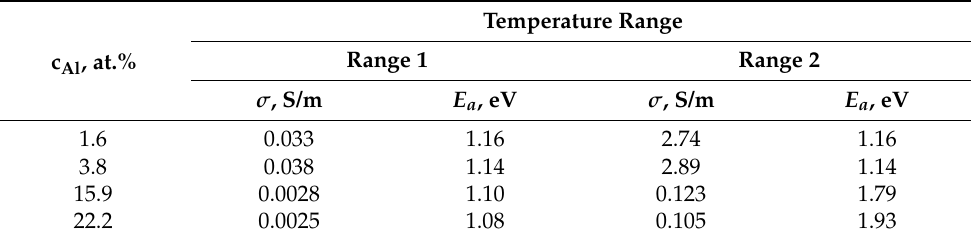
Table 3. Bulk ionic conductivity ( σ bulk ) at 520 and 800 °C and their activation energy ( E a ) of 6ScAlSZ thin ceramic films formed at the different aluminum concentration (c Al ). Temperature Range c Al , at.%